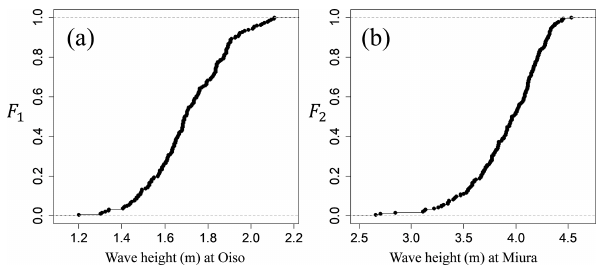
Figure 10. Empirical cumulative distributions of tsunami wave height ( a Oiso and b Miura) for source 8. Table 6. Maximum likelihood estimation results of each copula for source 8.